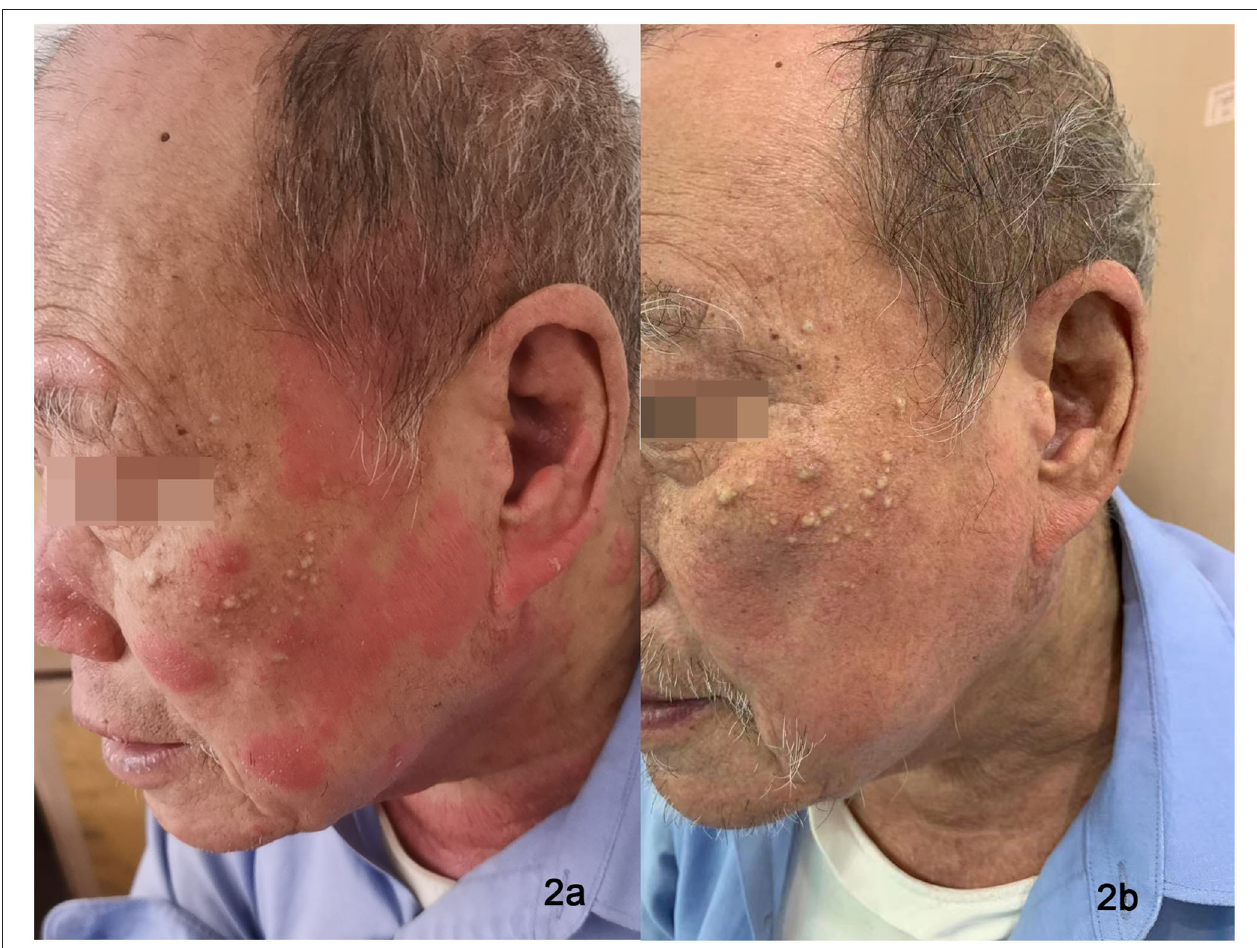
FIGURE 2 | Eczematous, scaly, and excoriated plaques on the face of Patient 2 before treatment (a) . Nearly clearance of lesions after dupilumab treatment (b)